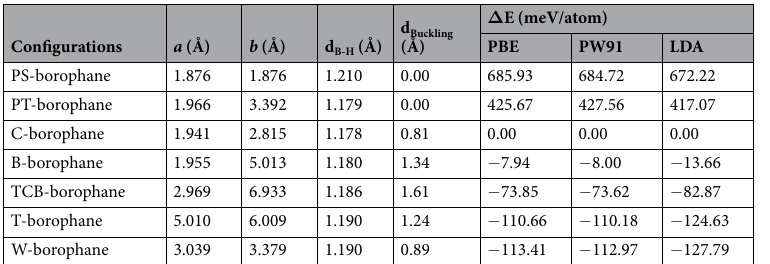
Table 2. The lattice constants, B-H bond lengths d B-H , buckling heights d Buckling and the total-energy difference relative to C-borophane at PBE, PW91 and LDA level of PS-, PT-, C-, B-, TCB-, T- and